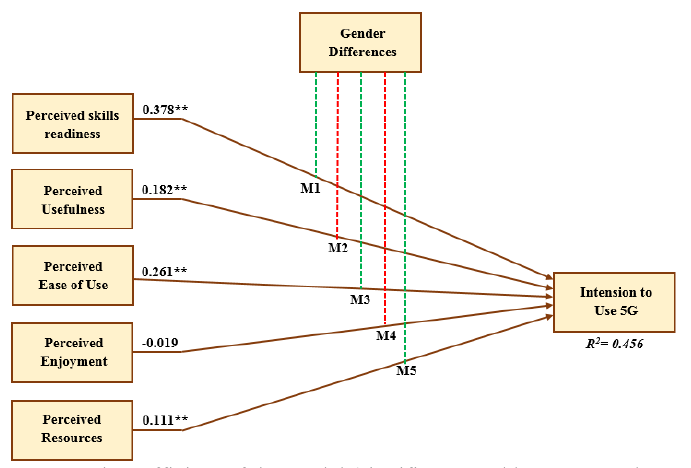
Fig. 2. Path coefficient of the model (significant at p** < = 0.01, p* <